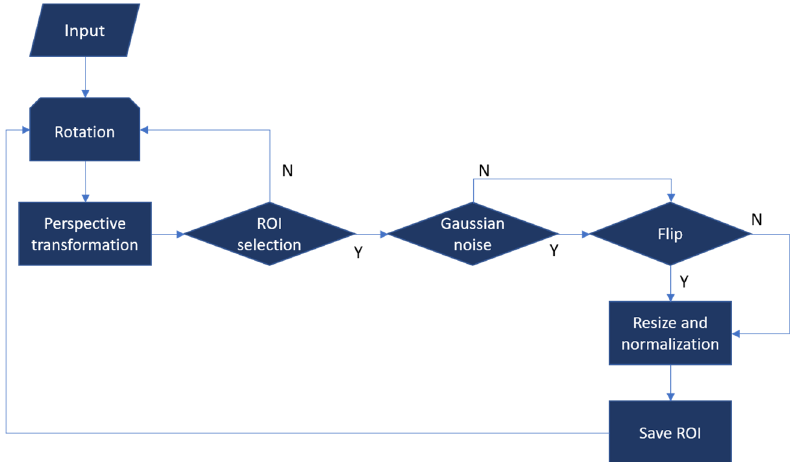
Figure 4. Data augmentation process for training data. Y and N represent the decision as to whether ROI can be selected, noise is added, and flipping is applied.